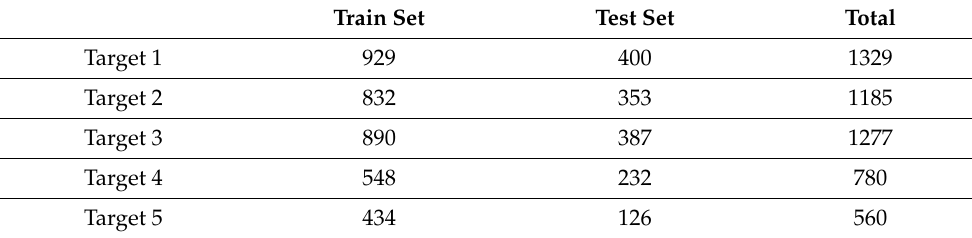
Table 6. Number of samples in dataset with data augmentation.